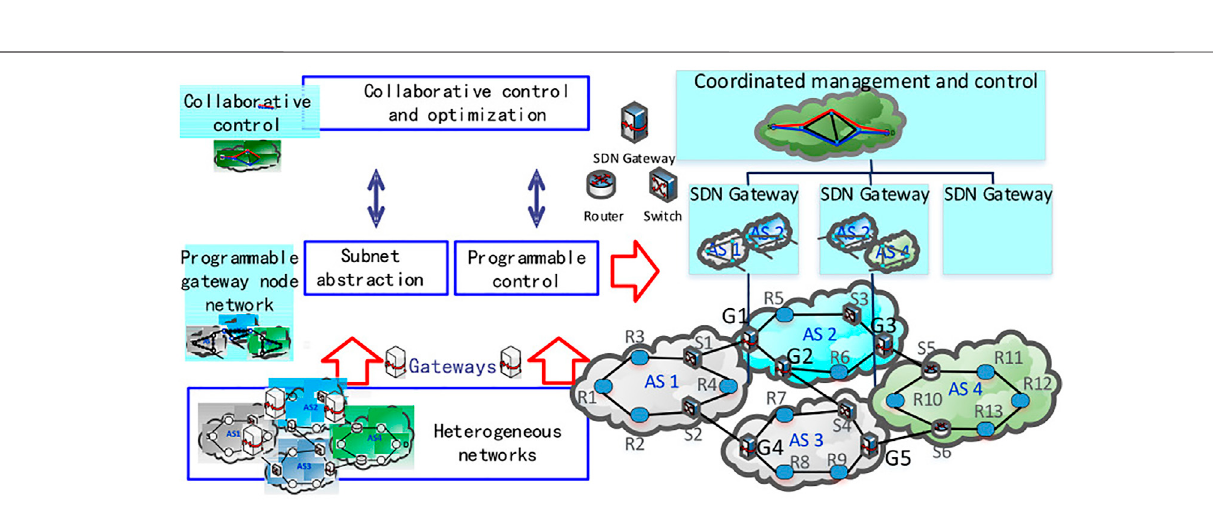
Frontiers in Communications and Networks |